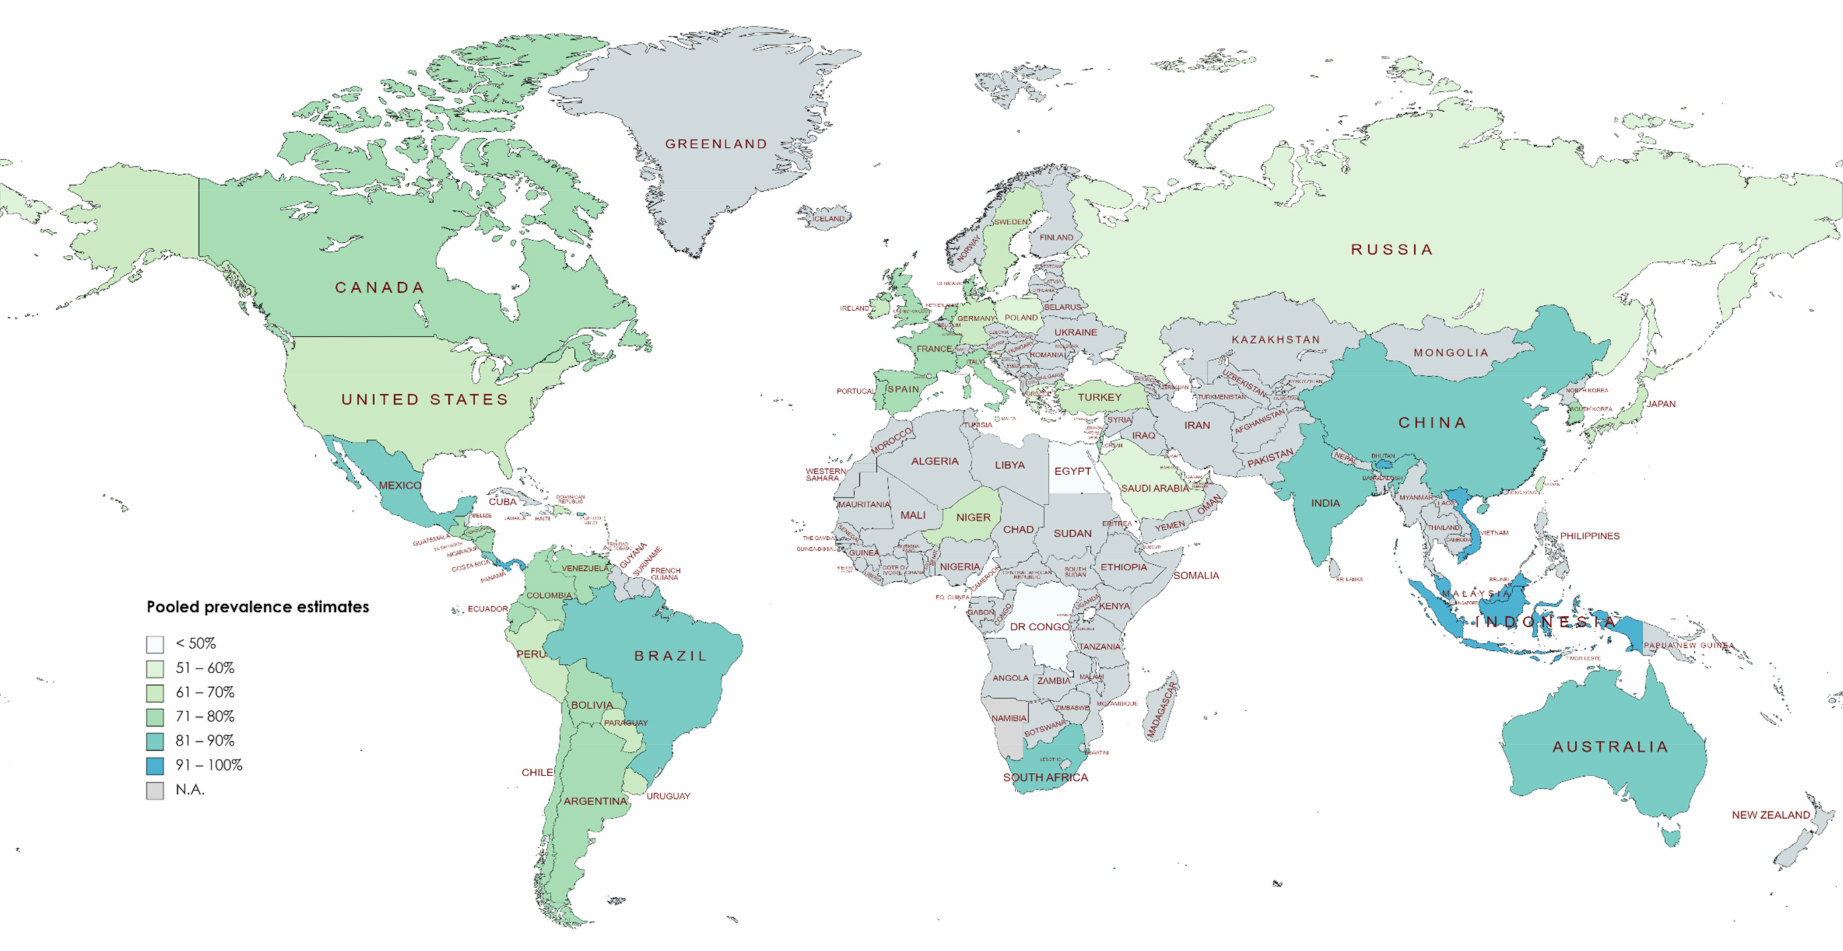
Figure 2. World map of pooled prevalence estimates of COVID-19 vaccination acceptance by country. NA: Not